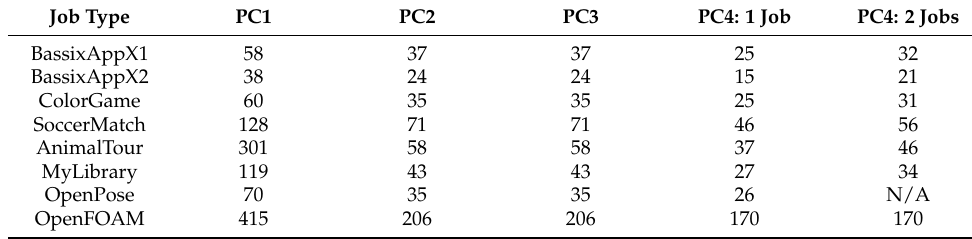
Table 4. Increasing CPU time at PC1 ∼ PC4 (s).